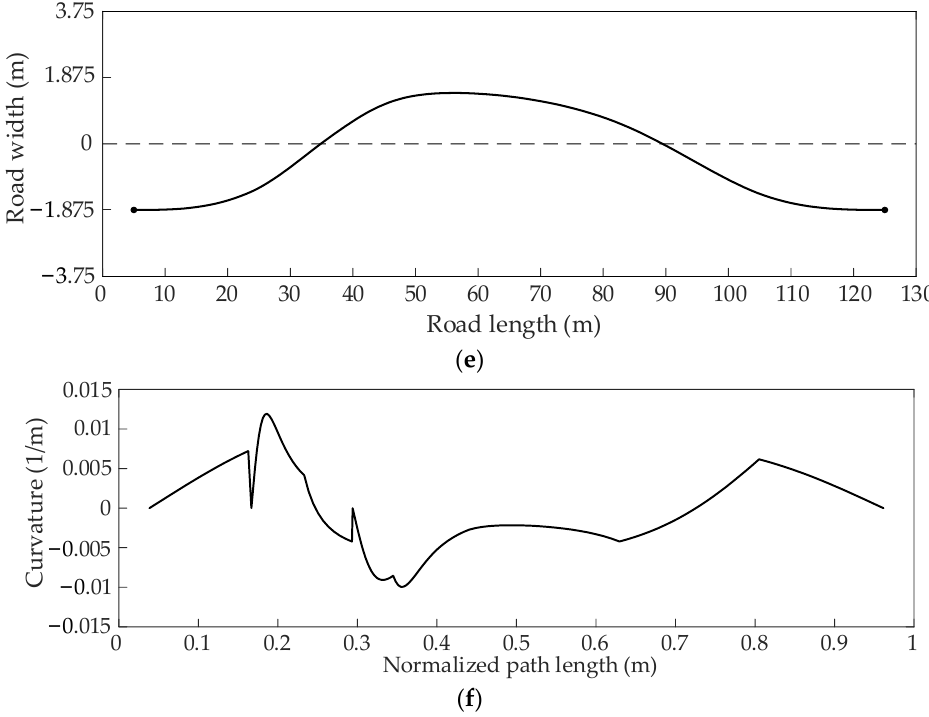
Figure 16. The path planning results in a dynamic scenario with driving in opposite directions. ( a ) The planned path in the first frame. ( b ) The planned path in the second frame. ( c ) The planned path in the third frame. ( d ) The path coherence process of three frames. ( e ) The coherence path of three frames. ( f ) The curvature of the coherence path.